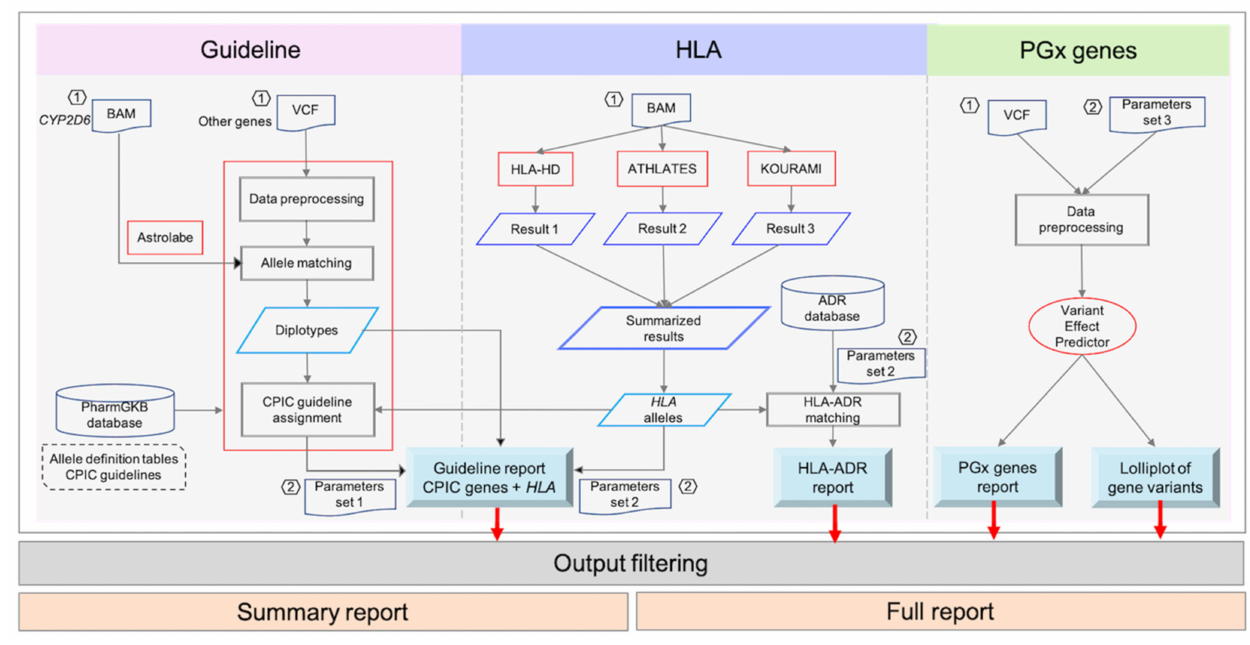
Figure 6. Overview workflows of the Guideline, HLA and Pharmacogenes analysis